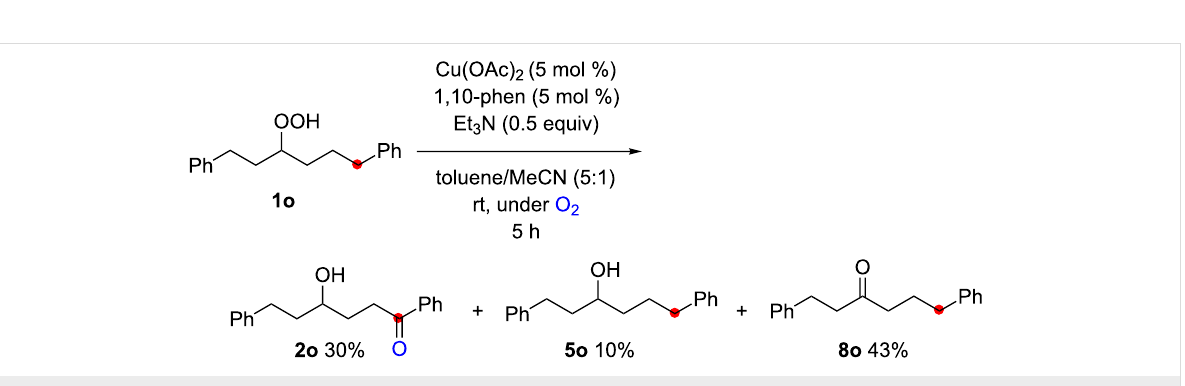
Scheme 5: The reaction of secondary hydroperoxide 1o